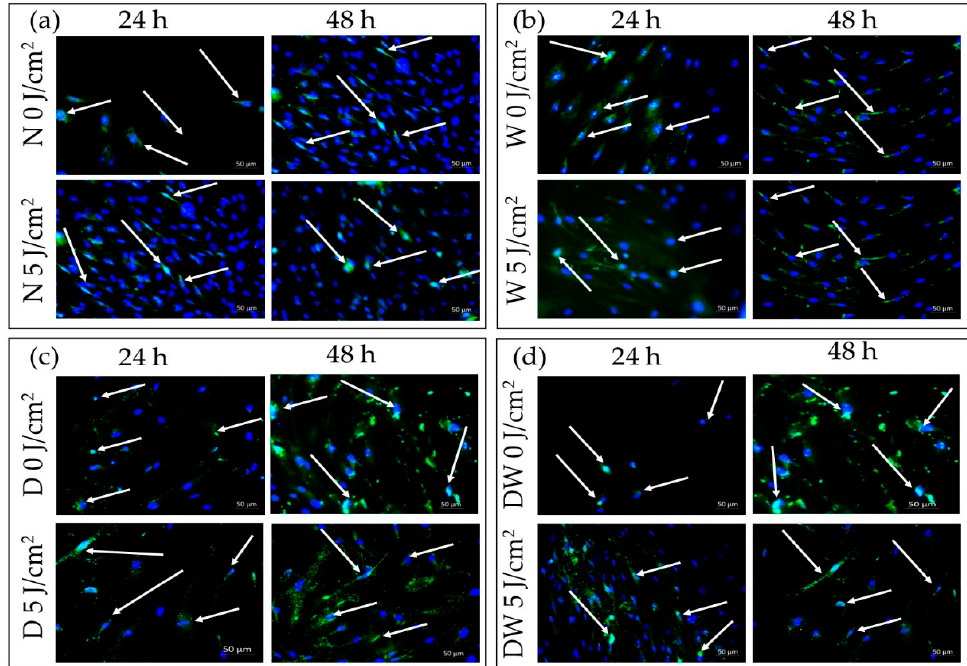
Figure 10. Immunofluorescence images of phosphorylated (p-) ERK1/2 (MAPK) in non-irradiated and irradiated normal (N) ( a ), wounded (W) ( b ), diabetic (D) ( c ), and diabetic wounded (DW) ( d ) cells at 24 and 48 h after irradiation at 660 nm with 5 J/cm 2 . Phosphorylated protein appears green (FITC; green signals), while the nuclei appear blue (DAPI; blue signal); 200× magnification.